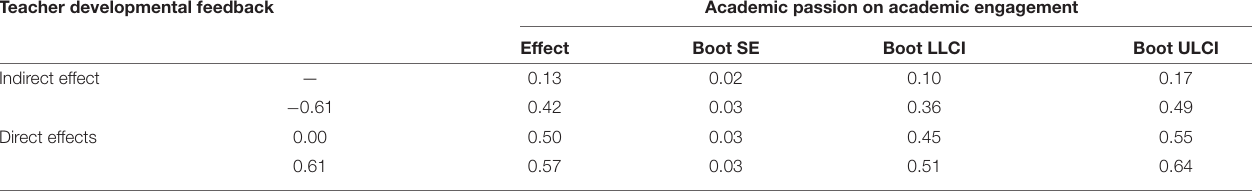
TABLE 3 | Effects and 95% confidence intervals for model